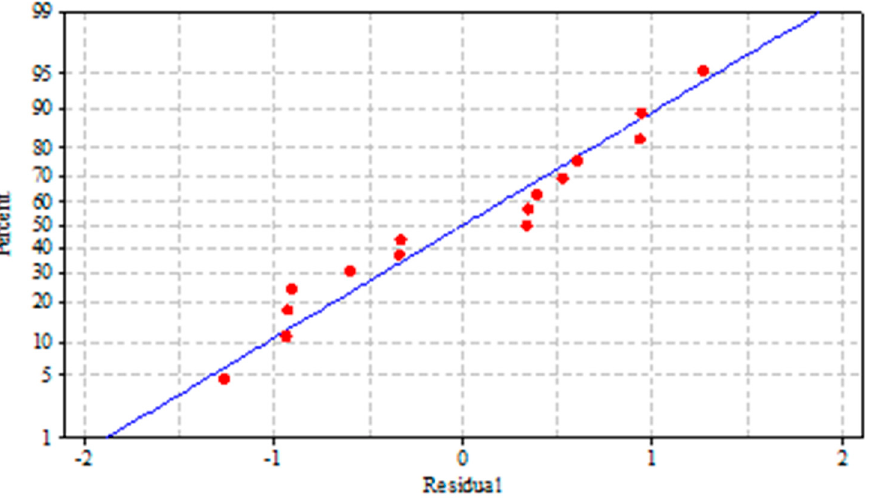
Figure 2. Normal probability plot of the residuals for MRR.